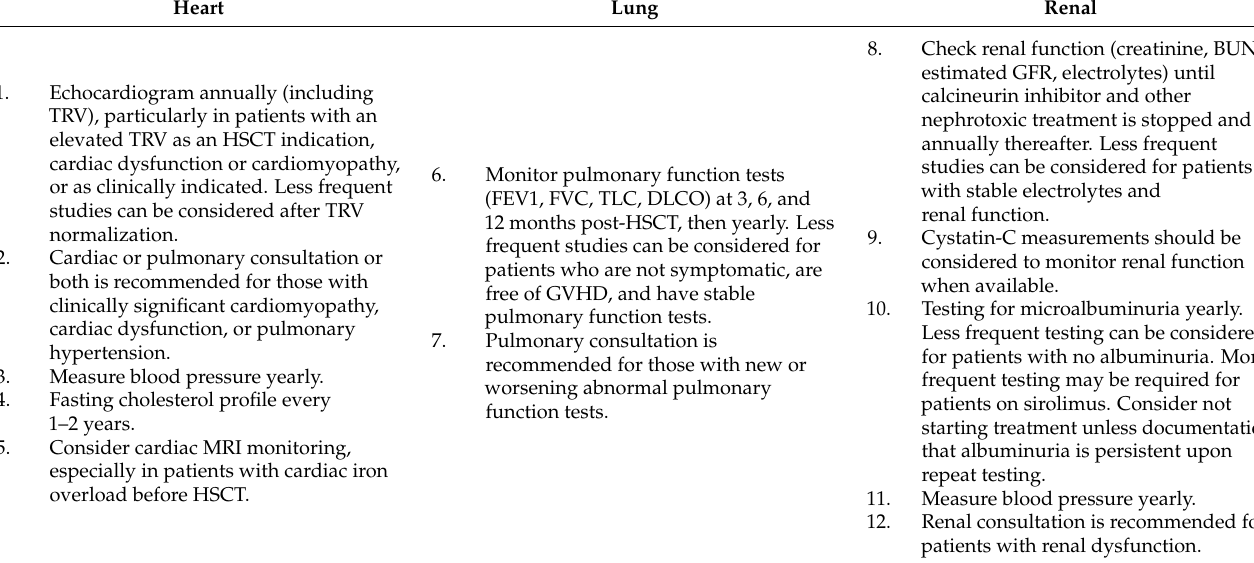
Table 5. Long Term Follow-up Considerations for Heart, Lung, and Kidney Disease Following Curative Therapies for Sickle Cell Disease Based on Available Limited